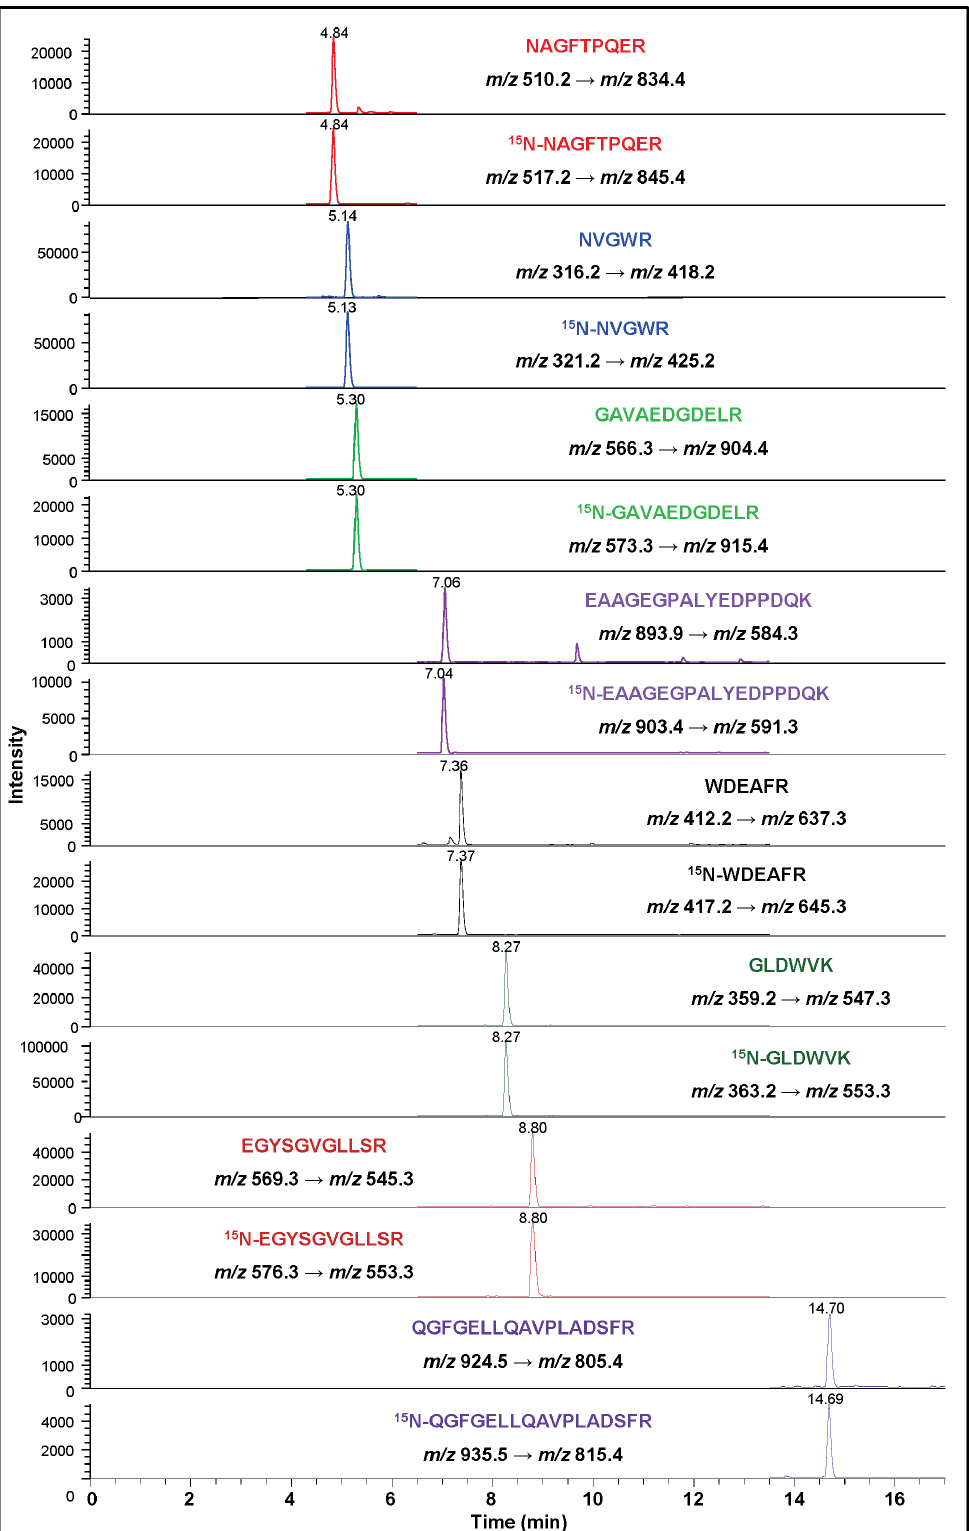
Figure 4. Ion-current profiles of mass transitions of eight tryptic peptides of hAPE1 and 15 N-hAPE1 obtained using the tryptic hydrolysate of a protein fraction, which was collected during separation by HPLC of a nuclear extract of MCF-10A cells. The extract was spiked with an aliquot of 15 N-hAPE1 prior to separation. Peptides and monitored transitions are shown.